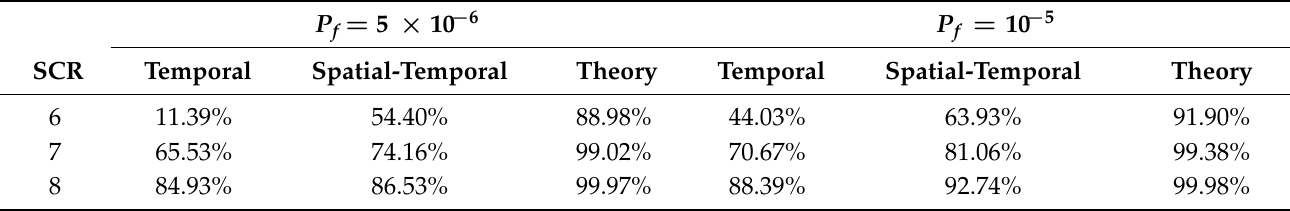
Table 1. P d achieved by three methods under different SCRs and P f .